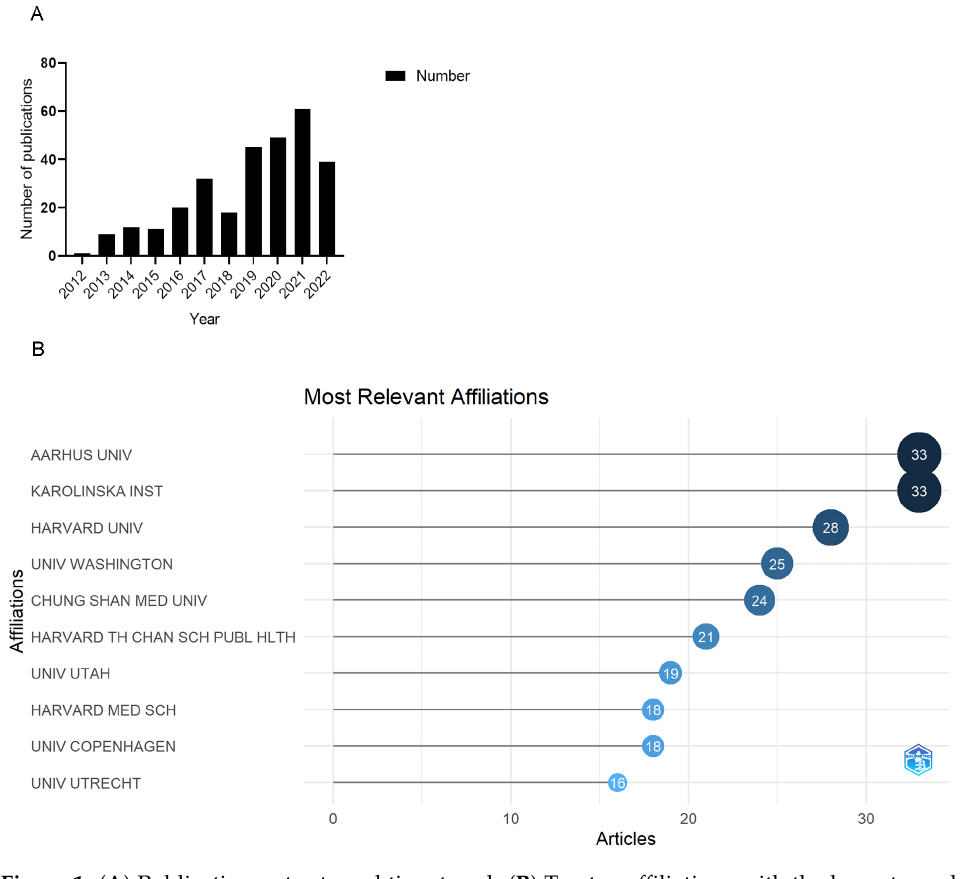
Figure 1. ( A ) Publication outputs and time trend. ( B ) Top ten affiliations with the largest number of